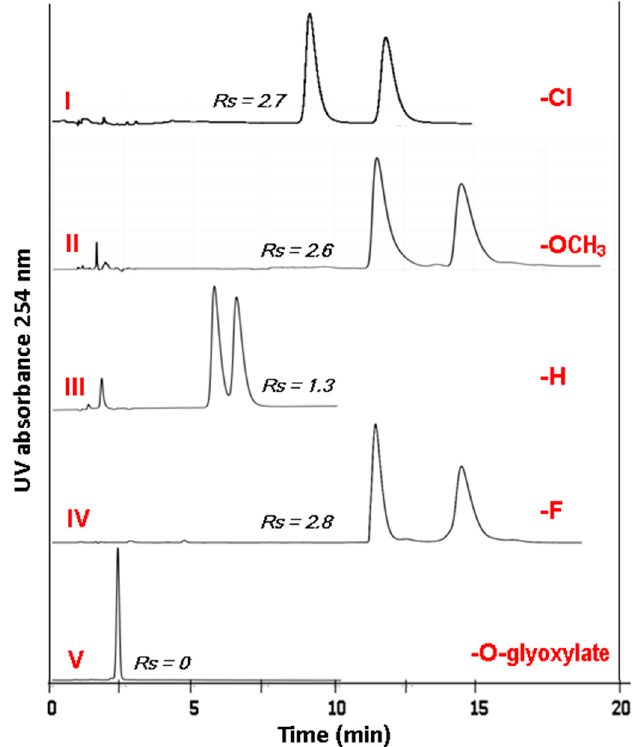
Figure 4. Chromatograms of the five oxazole compounds obtained on the MaltoShell chiral col- umn, all eluted with the same heptane-ethanol 80:20 % v / v normal mobile phase; 30 °C, 1 mL/min, UV 254 nm. See Table 1 for compound codes; the structural difference is pointed out on the right.